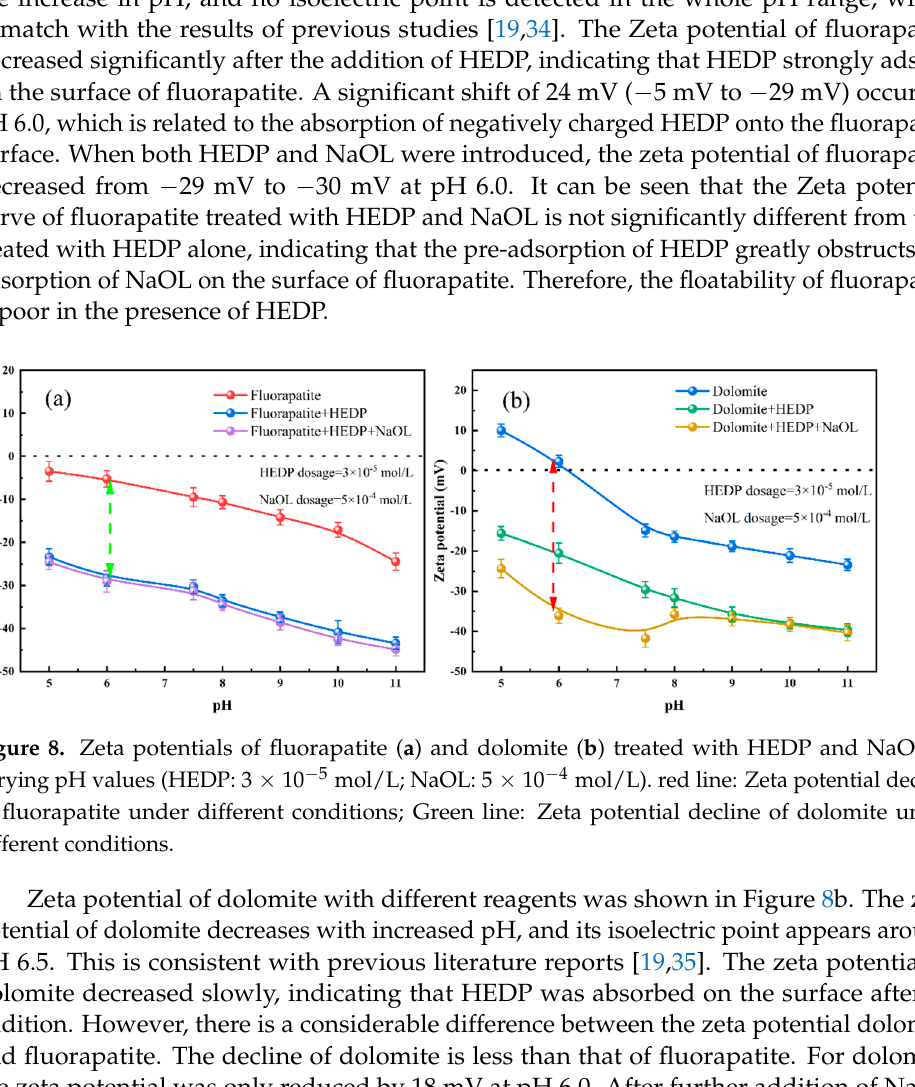
Figure 9. XPS wide-scan spectra of fluorapatite ( a ) and dolomite ( b ) before and after reaction with HEDP and NaOL.